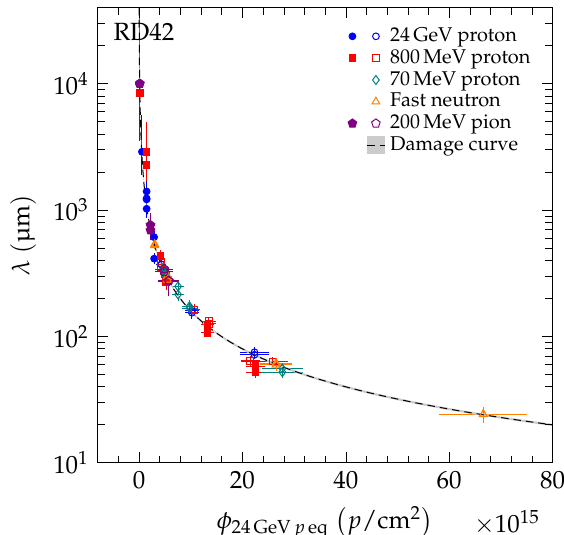
Figure 11. The λ for scCVD (solid markers) and pCVD (open markers) diamond. The fluence of each point was scaled by the relative damage constant to the 24GeV proton equivalent fluence. Each point is shifted by φ 0, j which represents the starting value of sample j in 24GeV proton equivalent fluence space. The dashed line is the fit of the damage model in Equation (3) to the data points. The gray band indicates the variation of the fit parameters by one standard